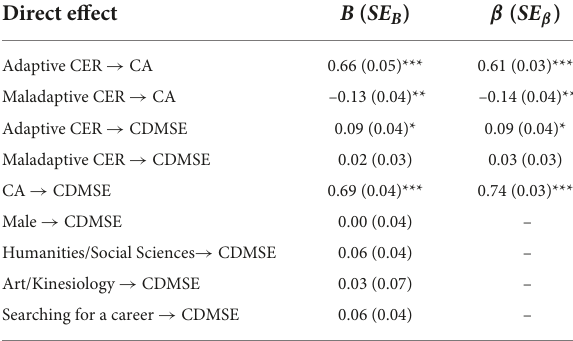
TABLE 4 Path analysis